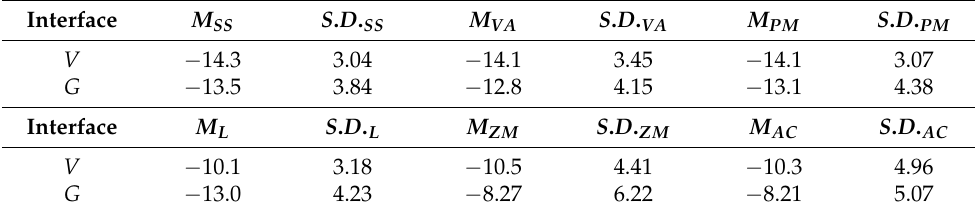
Table 10. Mean LCI ( M ) and standard deviations ( S . D